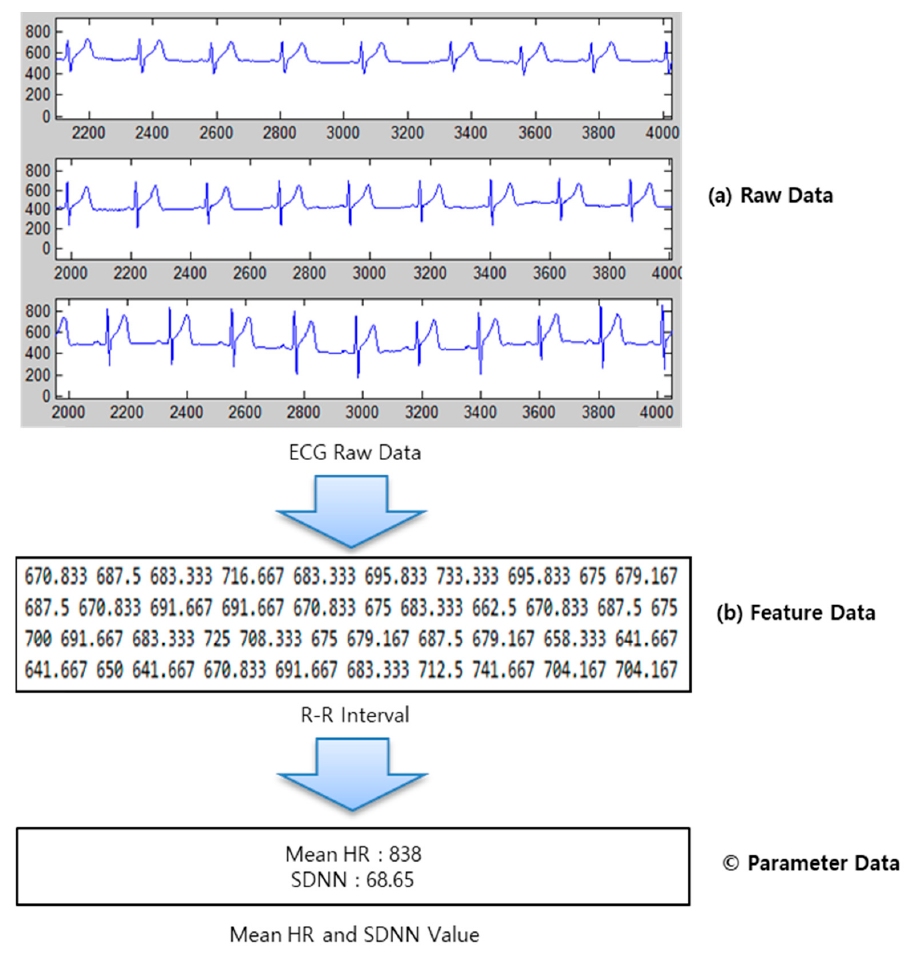
Figure 2. Characteristics of data according to the ECG signal analysis.